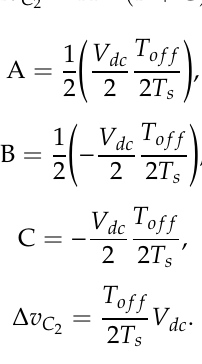
Figure 7. Simulation results of Figure 5; ( a ) gate voltage